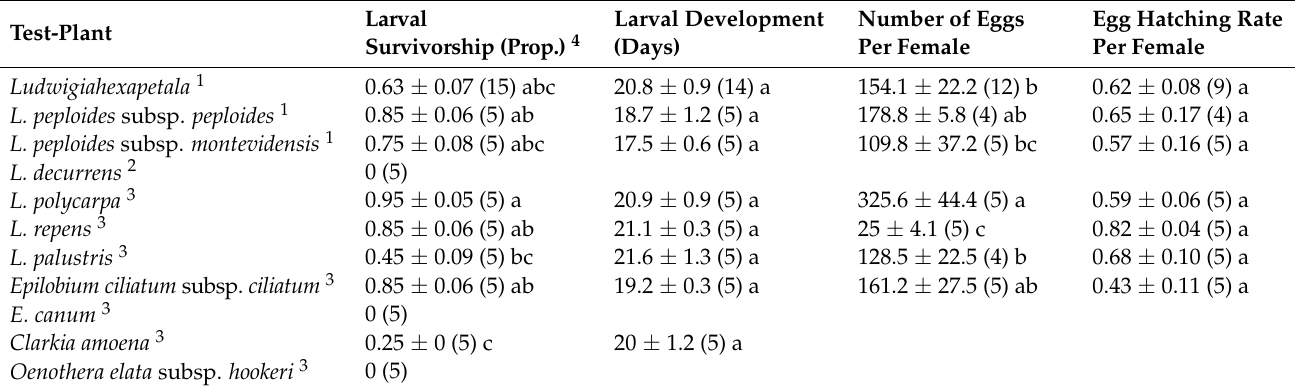
Table 1. Mean ± 1SE ( n ) larval survival and development (1st instar to adult), oviposition, and egg viability of Lysathia flavipes on exotic Ludwigia and native test plant species in no-choice host range tests. Test-Plant